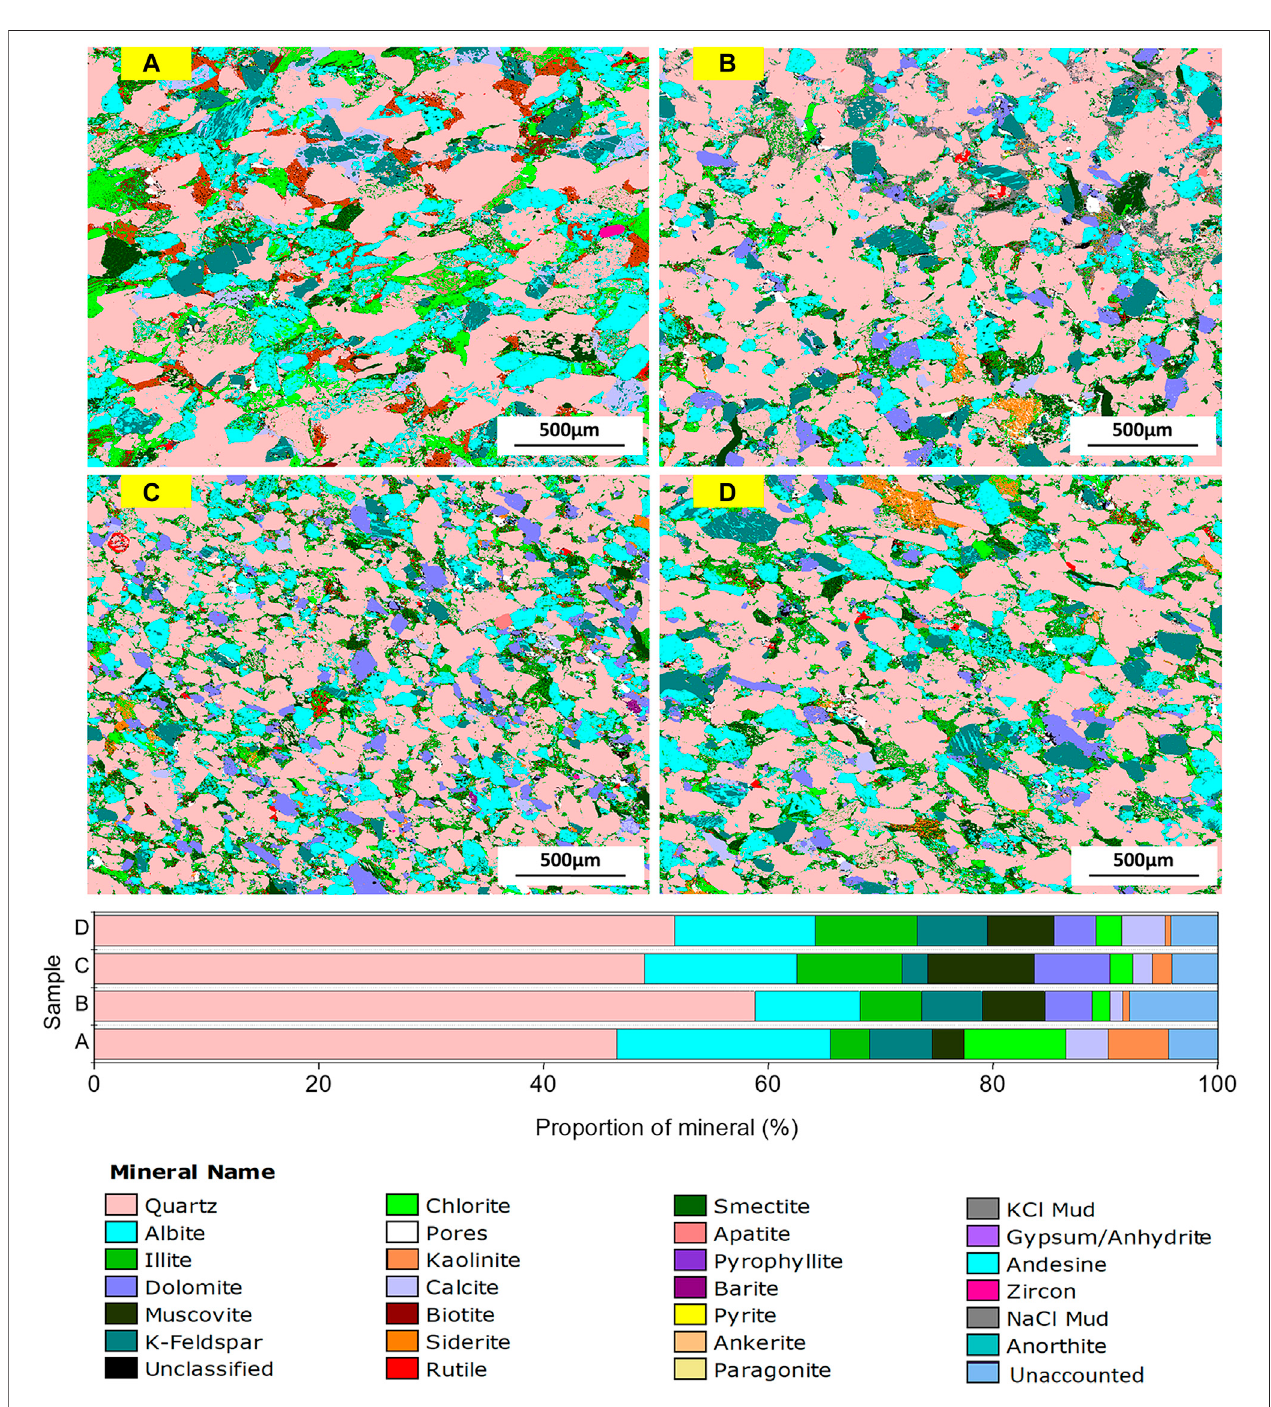
FIGURE 2 | Mineral composition of core sample A, B, C and D tested by QEMSCAN.